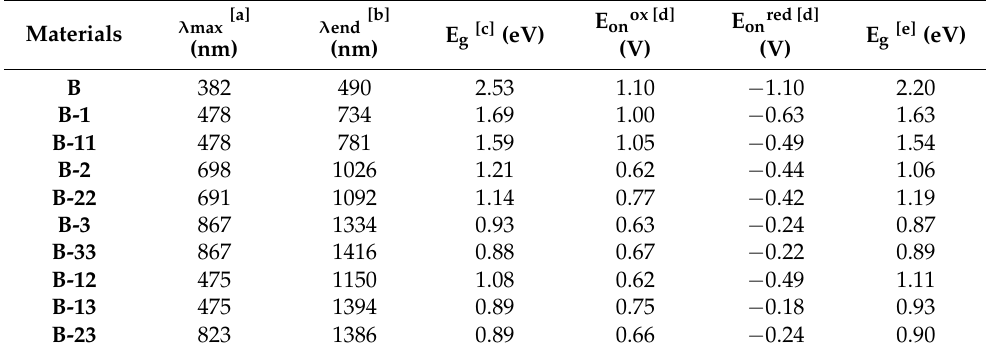
Figure 2. Ultraviolet/Visible captivating spectra of B , B-11 , B-22 , and B-33 in CH 2 Cl 2 solution, rt. Table 1. The electrochemical and optical properties of the compounds.